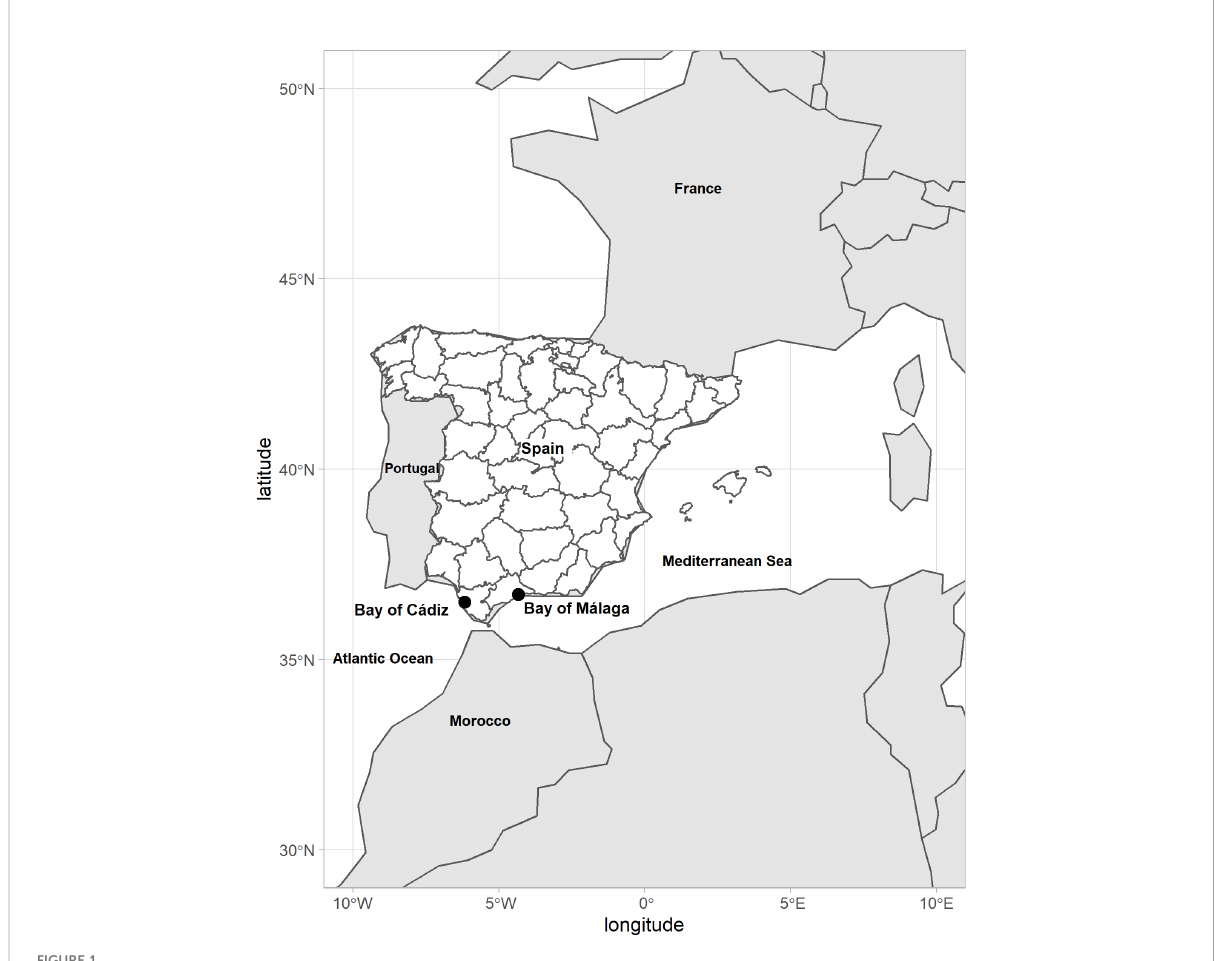
FIGURE 1 Map of Spain indicating the sites sampled in the present